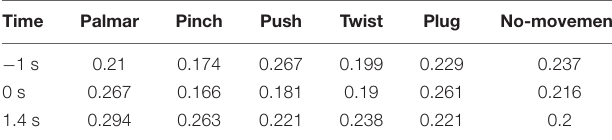
TABLE 3 | The density of network for each condition of S2.